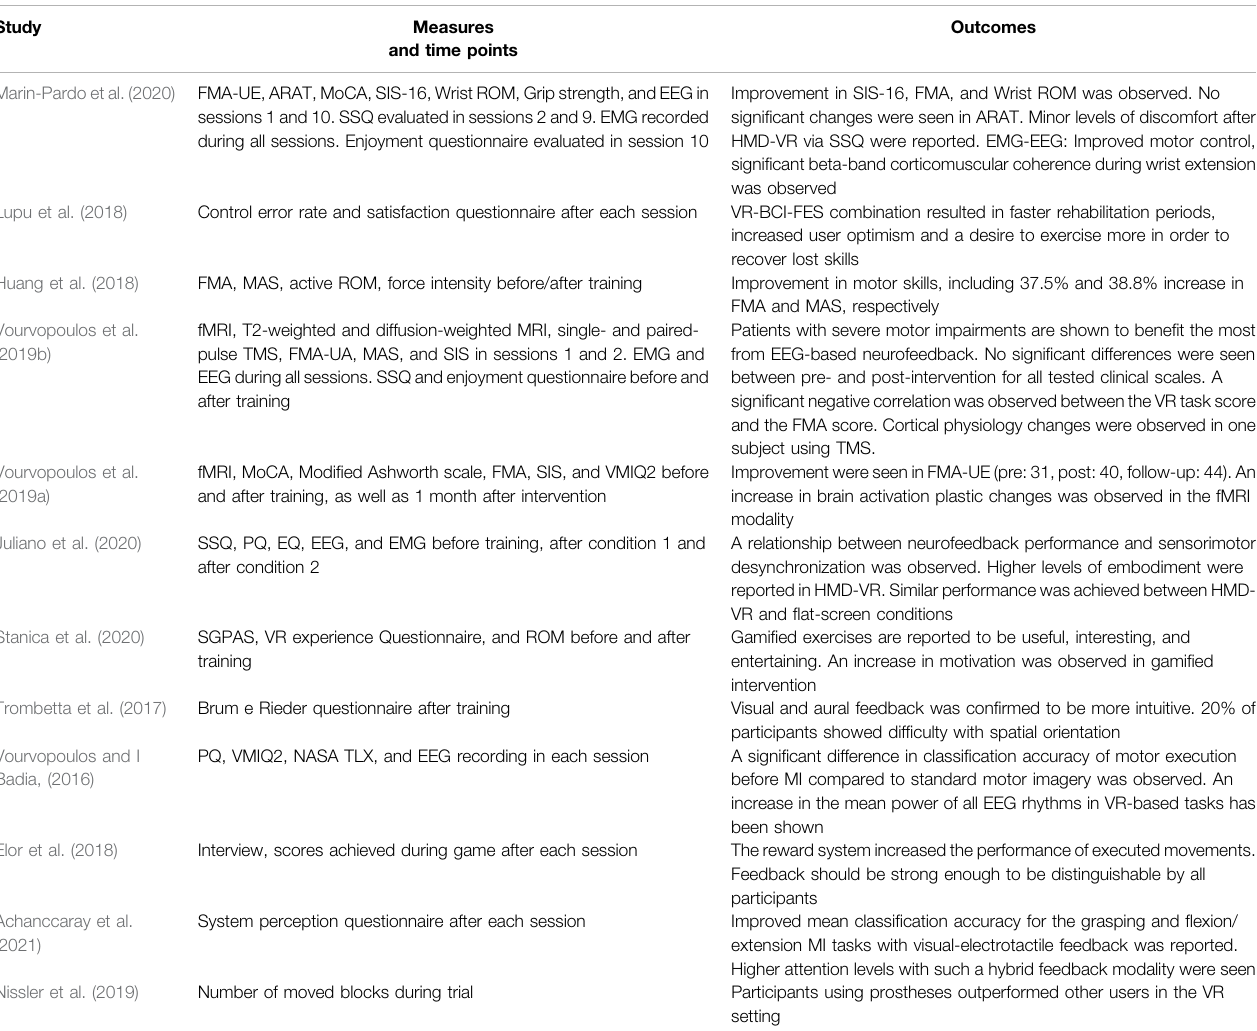
TABLE 6 | Measurement time points and clinical/non-clinical outcomes of each study. Study Measures and time